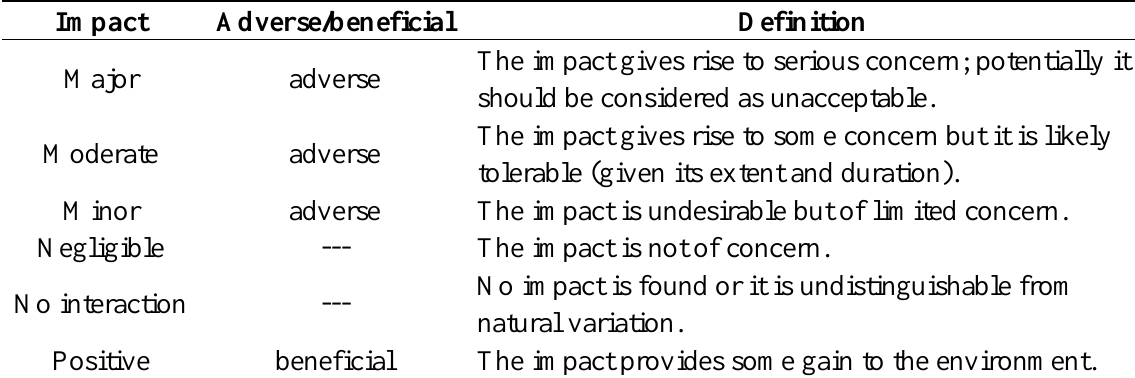
Table 1. Terminology for classifying and defining geo-environmental